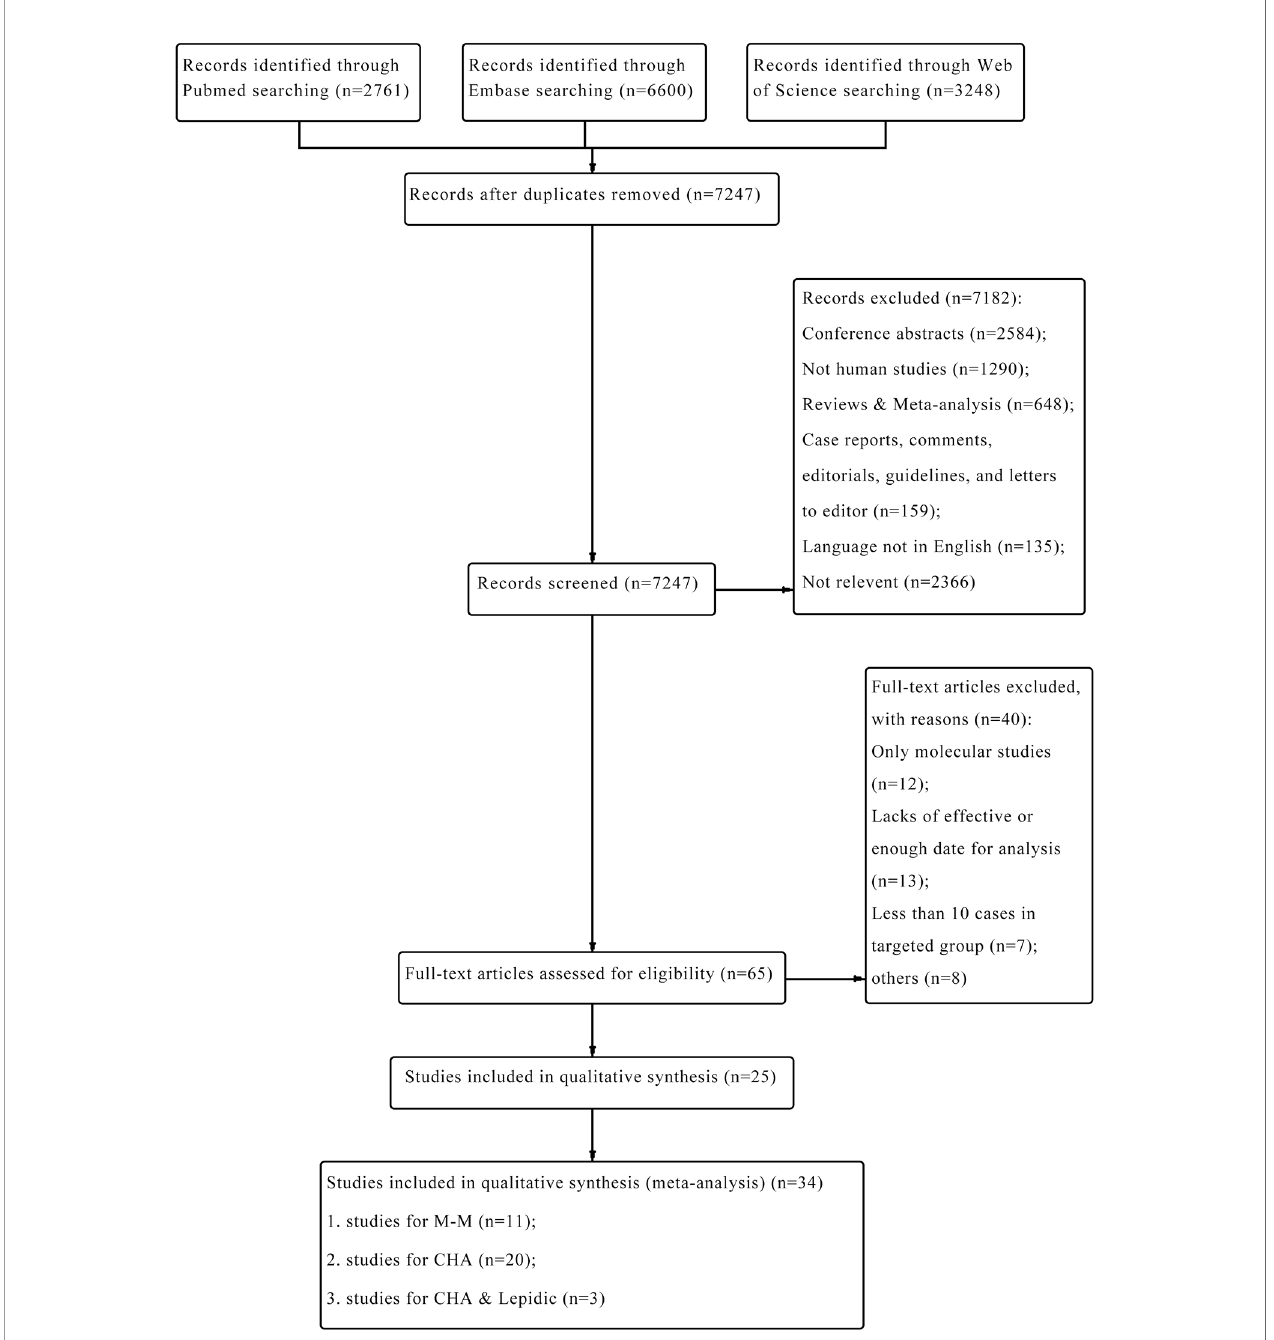
FIGURE 1 | The PRISMA fl ow diagram of the selected eligible